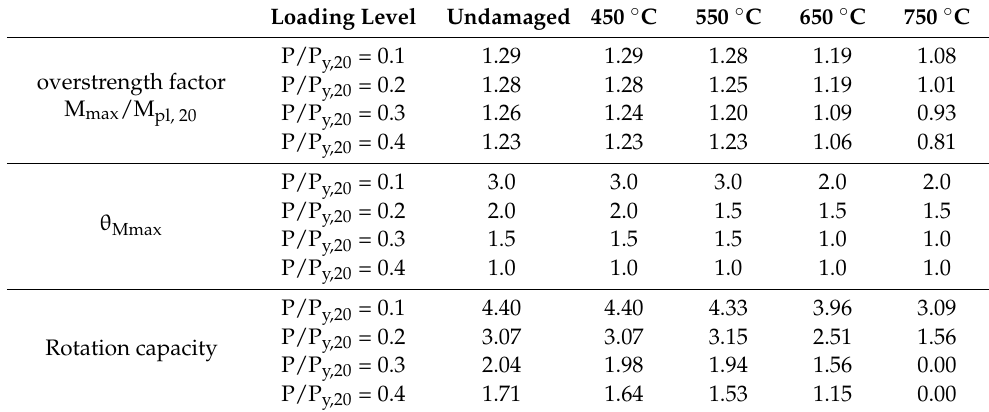
Table 3. Summary of the results for the HEB300